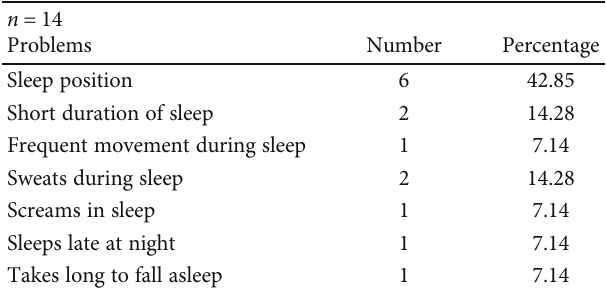
Table 5: Sleep problems reported by the